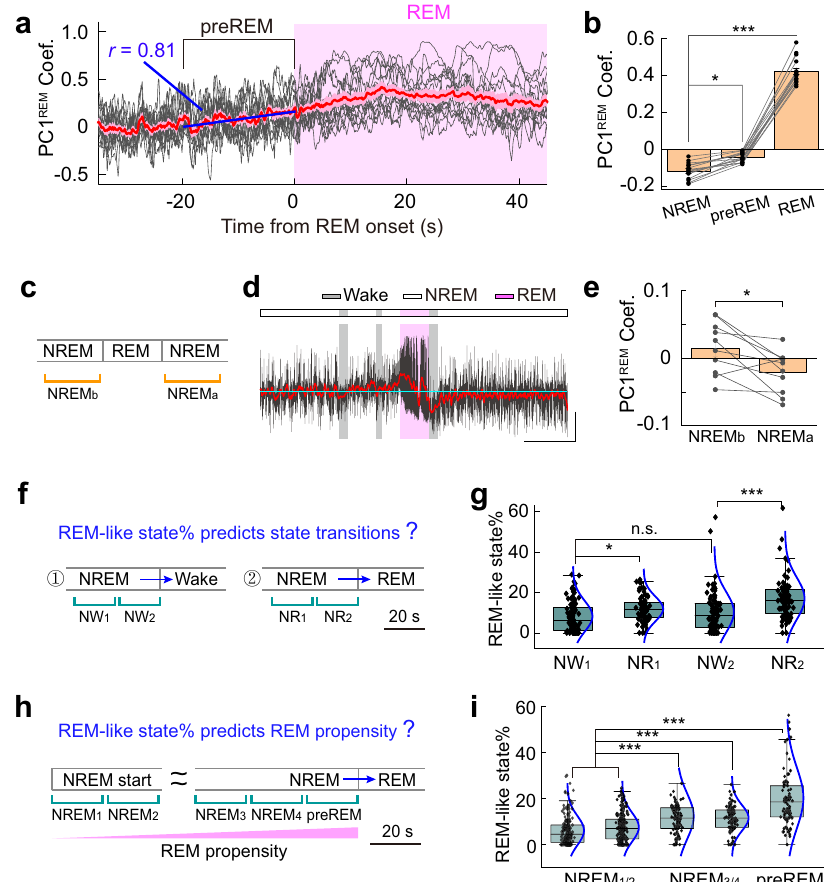
Fig. 6 | Activity in the occipital cortex signi fi esREM sleep. a Dynamic changeof the REM-like state during NREM-to-REMtransitions.Gray line, data fromindividual recordings.Red line,anaverageof 15recordingsfrom5mice.Shading isSEM.Blue line, a linear fi t of the average data during preREM (the 20-s immediately before REM onset). b Quanti fi cation of PC1 REM dynamics during NREM-to-REM transitions. P =0.036 for NREMvs. preREM; P <0.0001 for NREM vs. REM; Two-tailed paired t - test. n =15 recordings from 5 mice. Data are mean±SEM. c Diagram showing dif- ferentNREMperiods. d AnexampleshowingdynamicchangesofPC1 REM beforeand after a REM bout. Scale, 0.5 and 100s. e Quanti fi cation of PC1 REM before and after REM bouts. P =0.011; Two-tailed paired t -test; n =10 recording from 5 mice. f Diagram describing the de fi nition of different periods of NREM before the NREM → Wake or the NREM → REM transitions. g Box-plot showing the quanti fi ca- tion of REM-like brain state in different NREM periods. Box, 25 – 75% range and